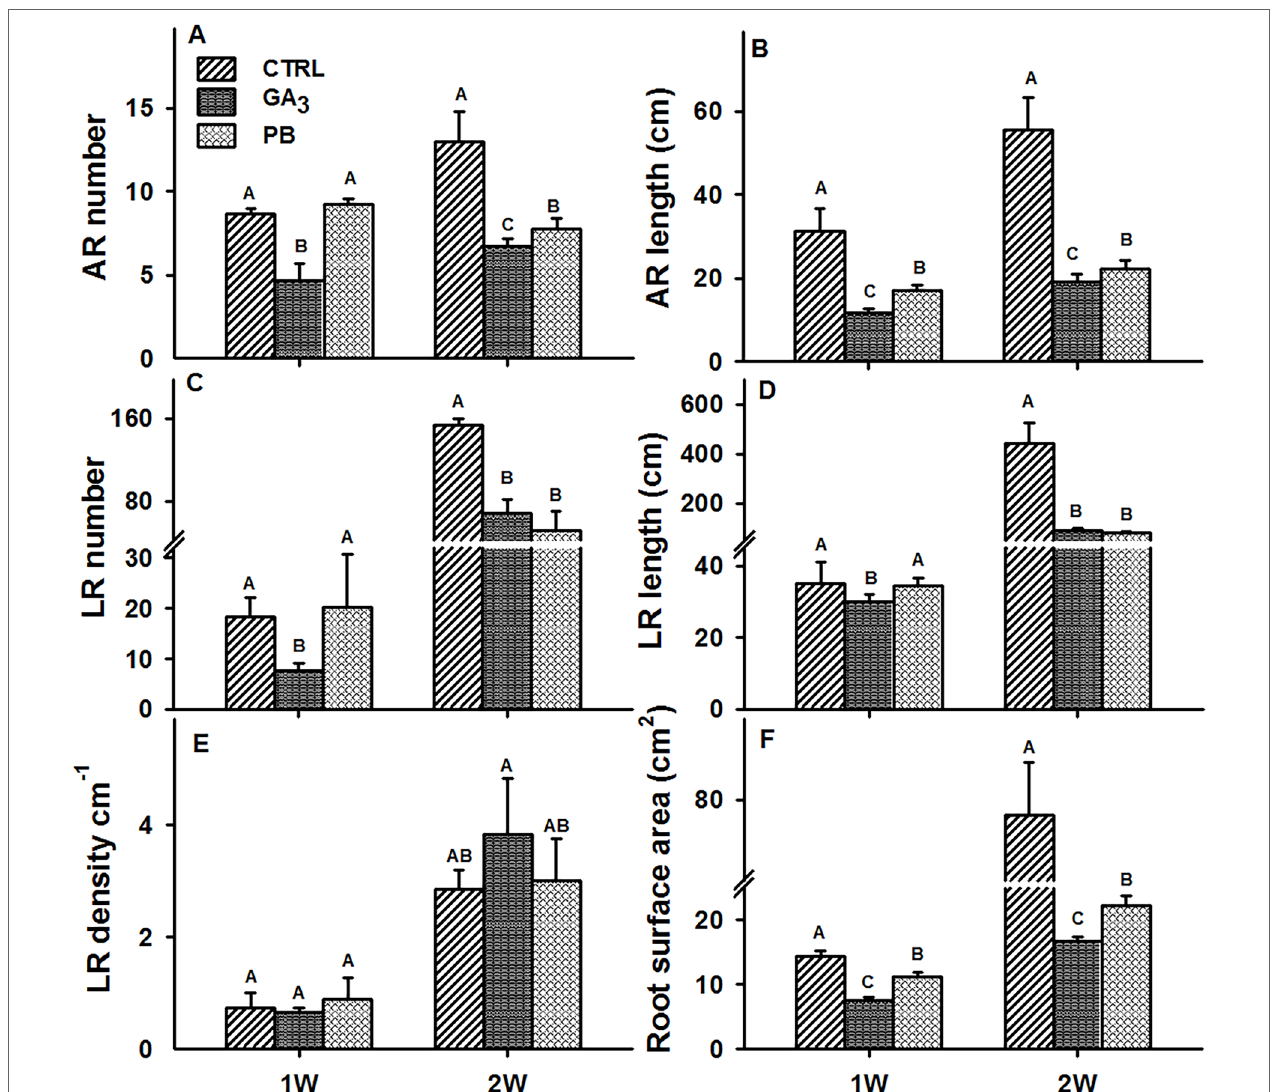
FiGURe 2 | Effect of GA 3 application on sweetpotato “ Georgia Jet ” root system architecture parameters. The parameters included adventitious root (AR) number per plant (a) , AR cumulative length per plant (B) , lateral root (LR) number per plant (c) , LR cumulative length per plant (D) , LR density per AR (e) , and root surface area per plant (F) , determined at one and two weeks (1W and 2W, respectively) after planting. Bars represent mean of four independent biological replicates (plants) ± SE. Significance analysis was performed by using student’s t-test ( P ≤ 0.05) , where unlike letters represent significant differences between treatments within a sampling group. CTRL, Control (treated with water); GA 3 , application of 50 ppm gibberellic acid 3 for two weeks; PB, application of 5 ppm paclobutrazol for two weeks.